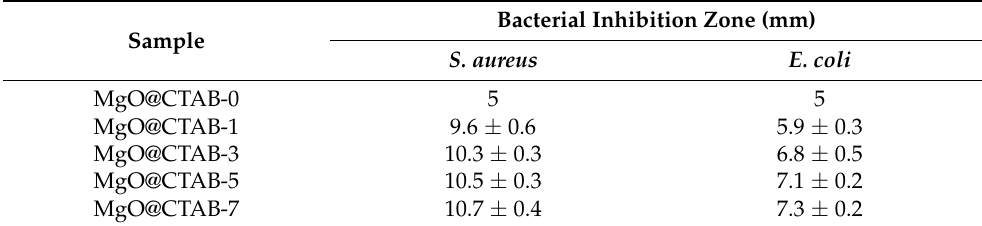
Table 4. Antimicrobial activity of PBAT nanocomposite films against S. aureus and E.